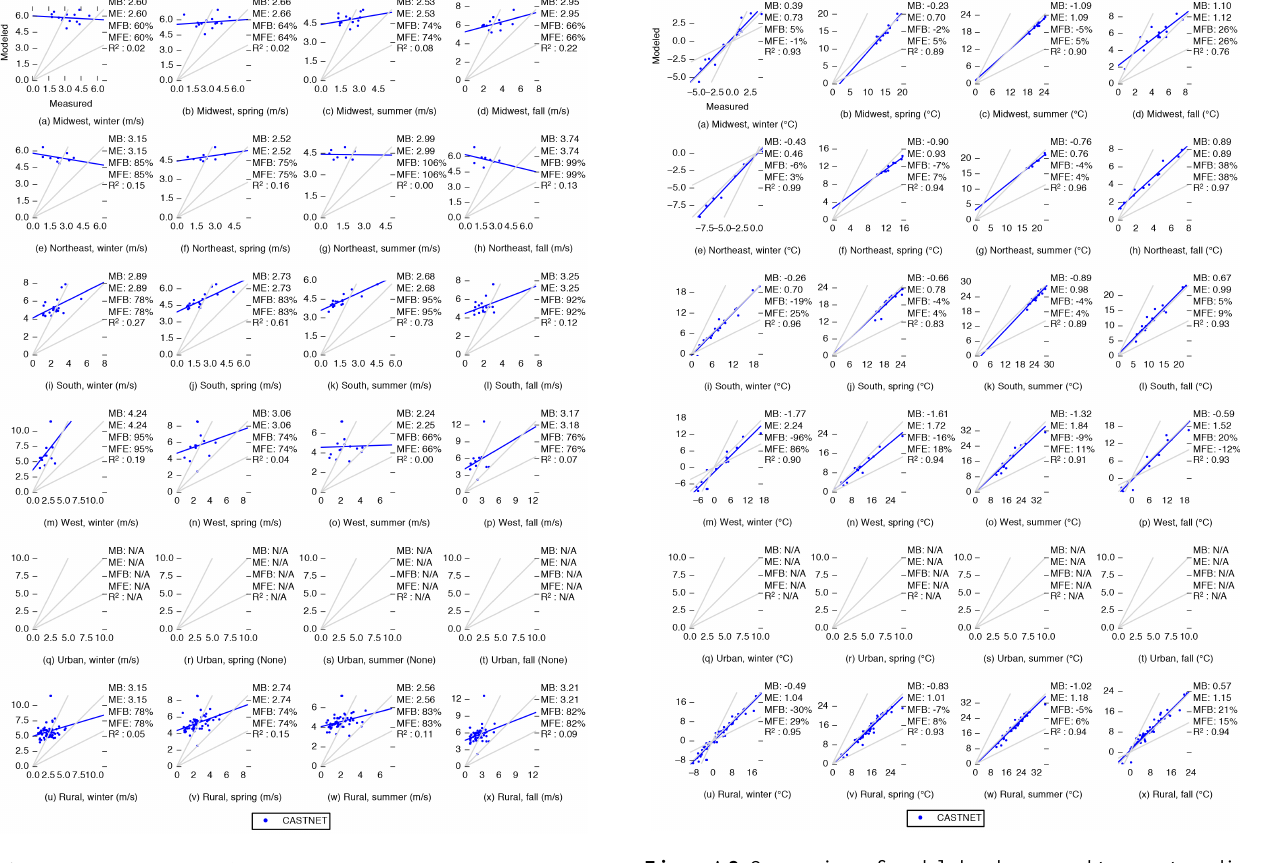
Figure A2. Comparison of modeled and measured wind speed, dis- aggregated by region and season.